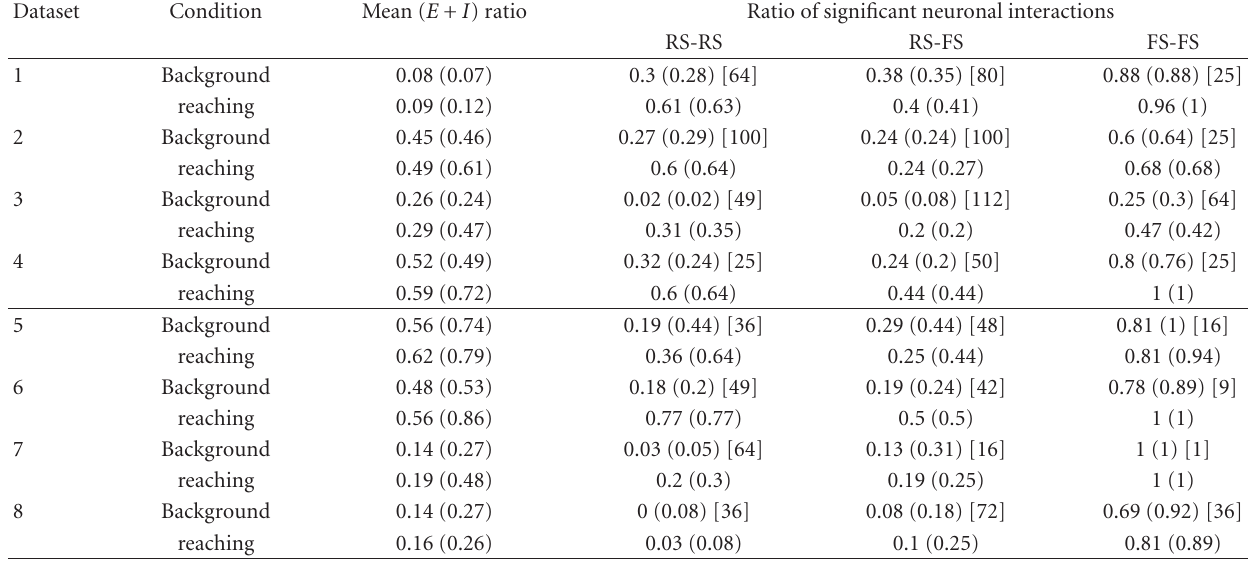
Table 3: The mean ( E + I ) connectivity ratio and the number of inferred significant neuronal associations (including self-interaction) in three cell-type subcategories in 8 datasets. The first two numbers in each column show the prevalence of connected neuronal pairs as a fraction of the total number of possible connections during unsuccessful and successful (in brackets) trials, respectively. The numbers in square brackets in the last 3 columns indicate the numbers of all possible pairwise neuronal associations (including self-interaction) for di ff erent data sets. Two neurons are said to interact if their pairwise connection coe ffi cients at any time lag are significantly di ff erent from 0. Note that in order to compute the fraction of significant neuronal interactions in the three cell-pair subcategories, we need to divide the listed raw numbers by the respective numbers in the square brackets in each